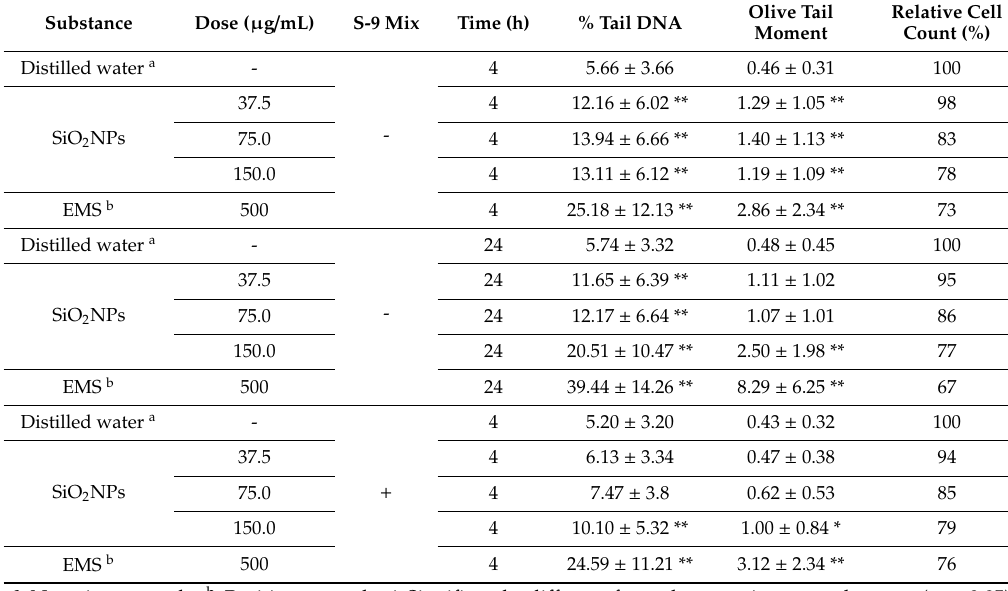
Table 5. Results of in vitro comet assay with SiO 2 NPs.